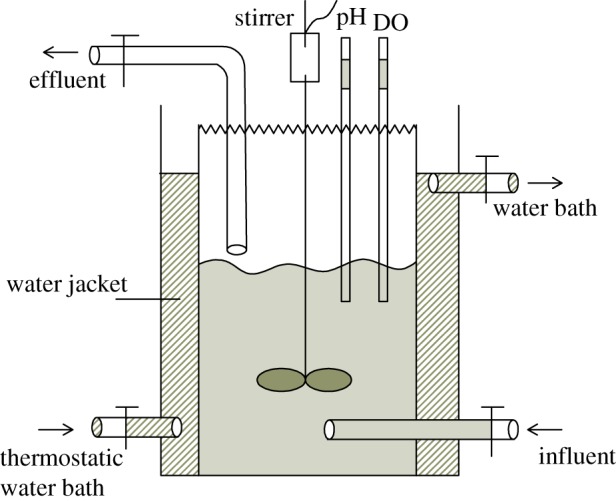
Schematic diagram of the reactor.